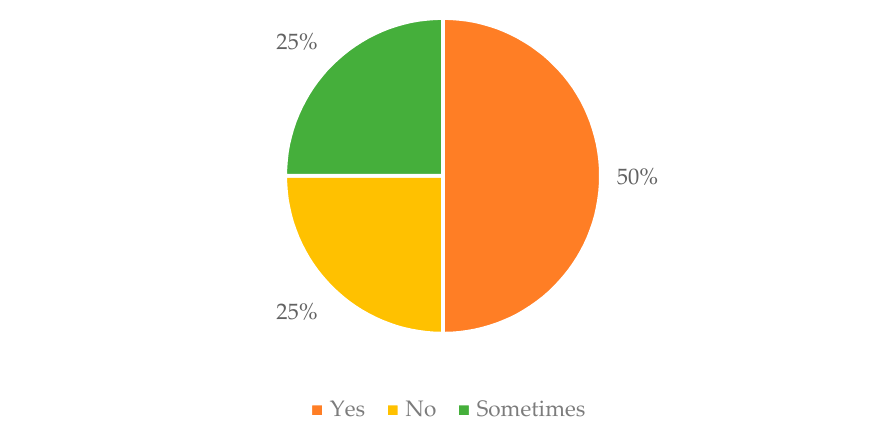
Figure 18. Evaluation participants’ willingness to complete pre- and post- sleep